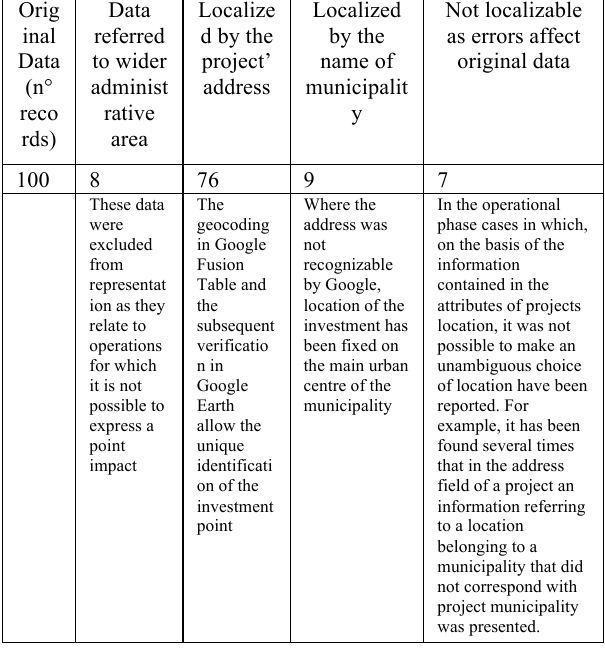
Table 1. Accuracy of territorialisation process.